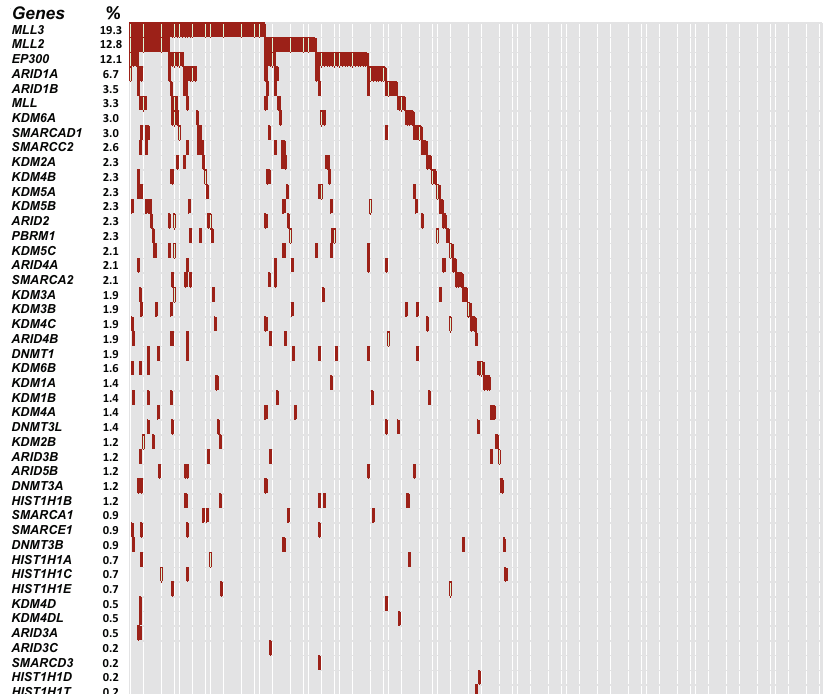
Fig. 2 Frequency of mutations in chromatin remodeling genes in cervical carcinoma. Gene names are sorted in order of frequency with % of patients with gene mutation indicated next to each gene name. Each column represents one patient, and a dark red color represents a mutated